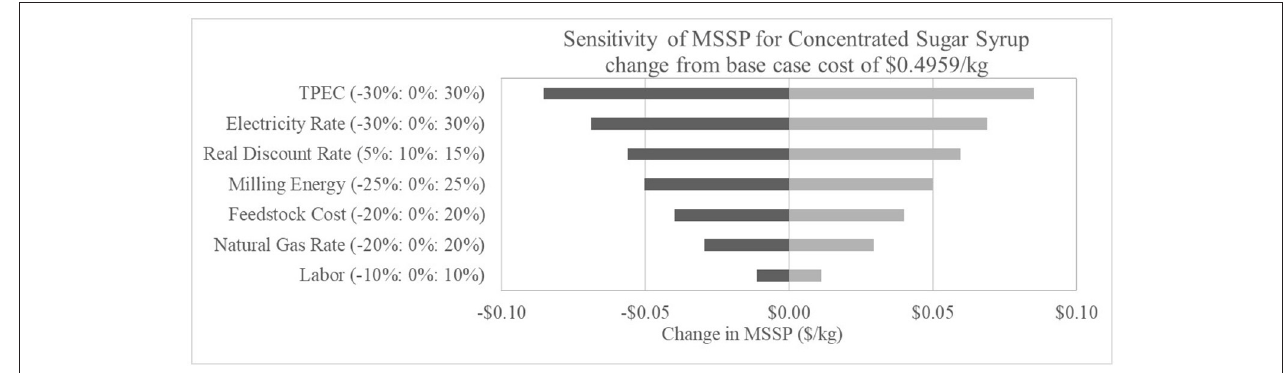
FIGURE 3 | Impact on cost of sugar production with changes from the base case, applied to major cost variables.